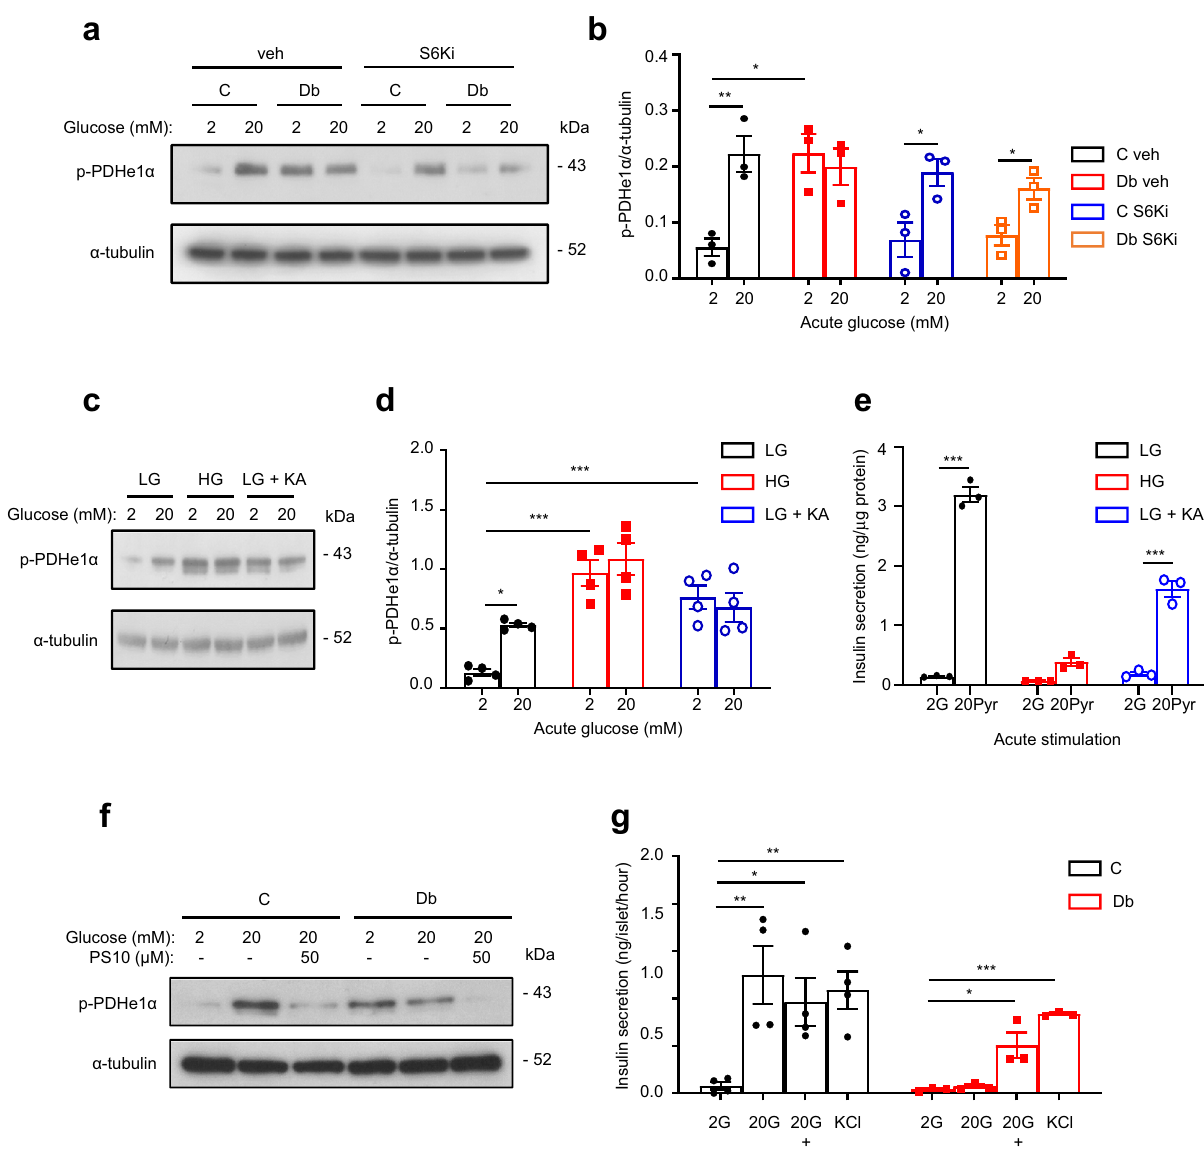
Fig. 9 | Effects of chronic hyperglycaemia, koningic acid and PS10 on PDH signalling. a Representative Western blot of lysates from control (C) and diabetic islets (Db) cultured in the presence or absence of 10 µ M S6-kinase inhibitor PF- 4708671 (S6Ki) and then stimulated with 2mM or 20mM glucose for 1h. Phos- phorylated (p) PDHe1 α . Loading control, α -tubulin. Uncropped blots in source data. b Quantitative densitometry analysis of p-PDHe1 α / α -tubulin ( n =3, 11 ani- mals/genotype). Control islets (black), Diabetic islets (red), Control islets+S6Ki (blue),Diabeticislets+S6Ki(orange).Veh,vehicle(0.05%DMSO). c Representative Western blot of lysates from LG-cells, HG-cells and LG-cells cultured for 48h with 5 µ M koningic acid (KA), then stimulated with 2mM or 20mM glucose for 1h. Phosphorylated(p)PDHe1 α .Loadingcontrol, α -tubulin.Uncroppedblotsinsource data. d Quantitative densitometry analysis of p-PDHe1 α / α -tubulin ( n =4